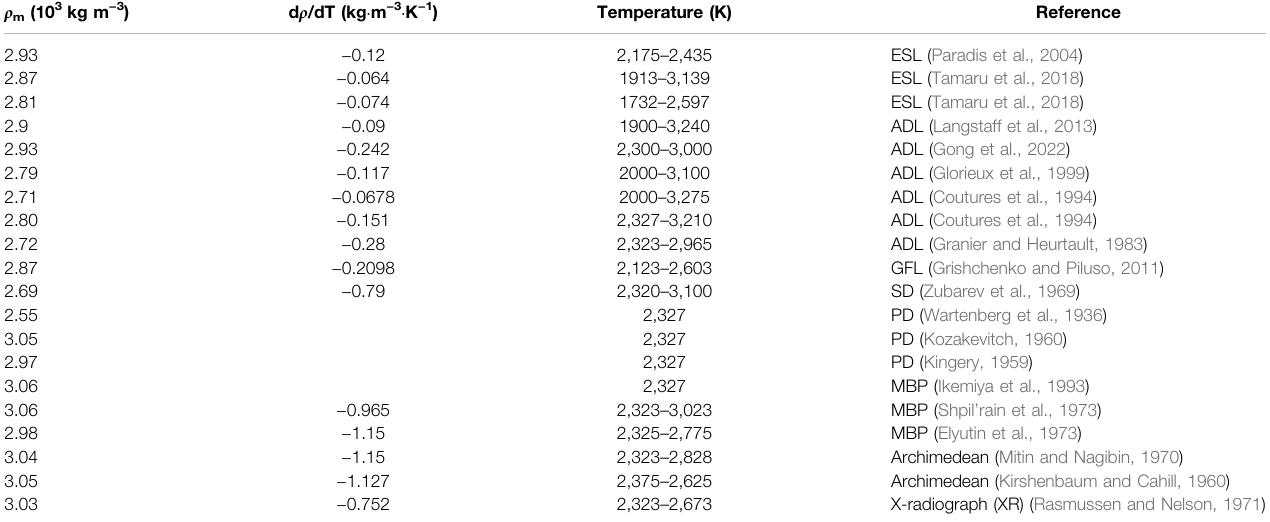
TABLE 1 | Density of molten Al 2 O 3 .